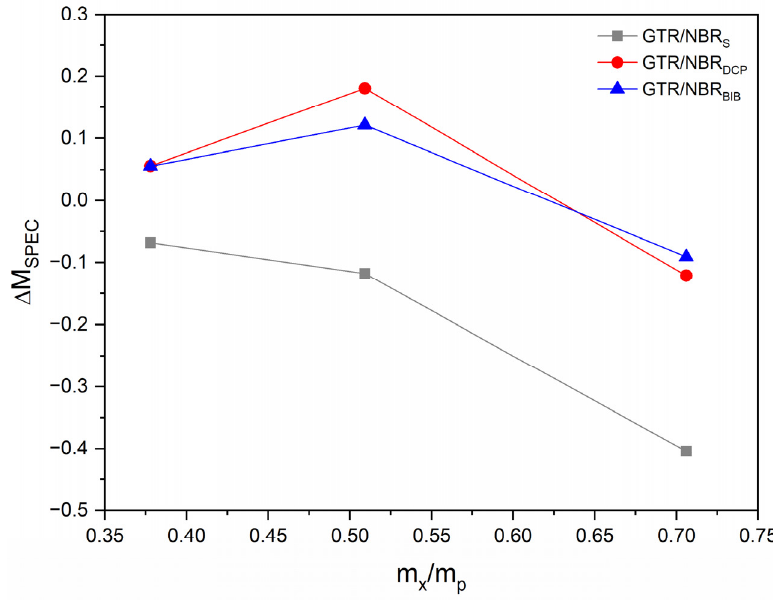
Figure 2. Wolff activity coefficient as a function of silica content for all applied systems.